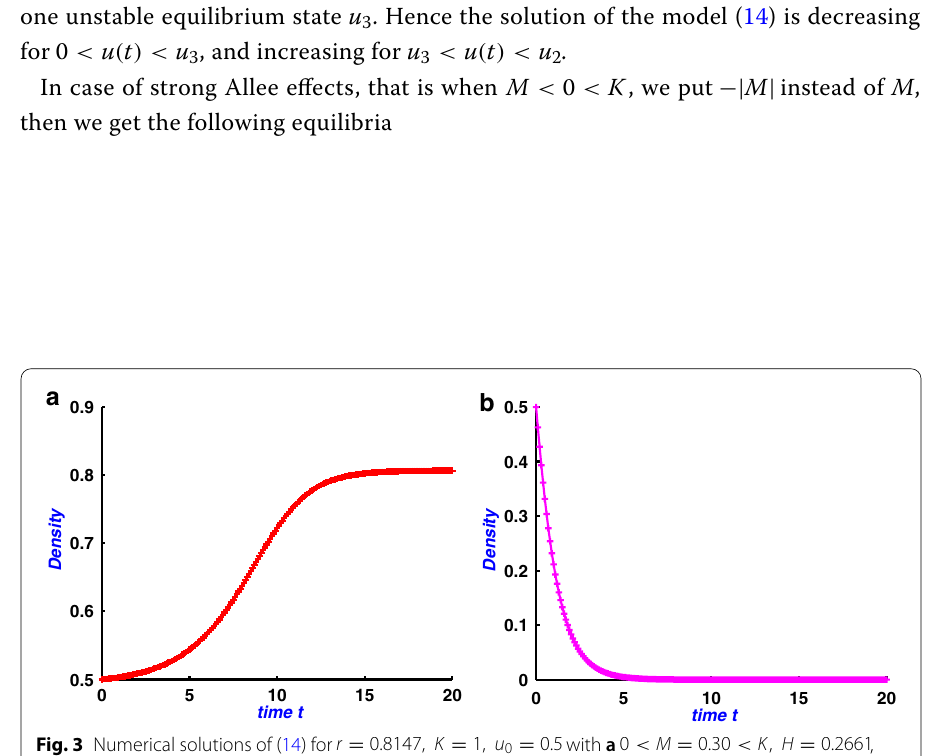
Fig. 3 Numerical solutions of (14) for r 0.9058 < 0 < K , H and a M = −